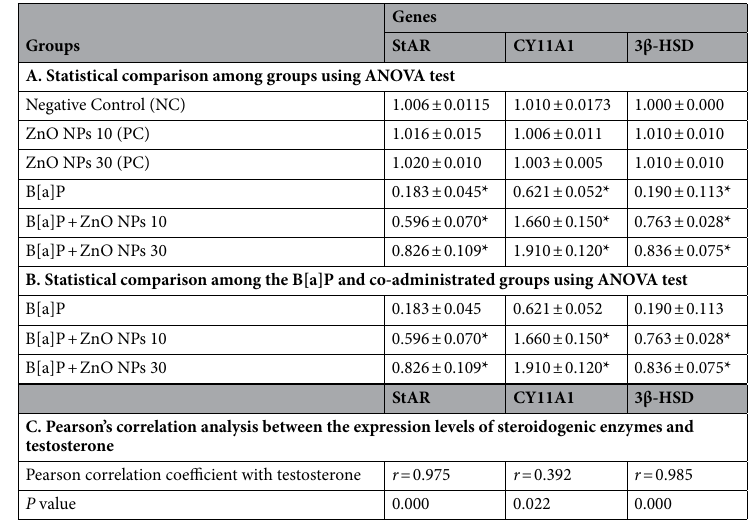
Table 2. Effect of zinc oxide nanoparticles (ZnO NPs) on the relative expression of steroidogenic enzymes in benzo [a] pyrene (B[a]P)-challenged male rats. Values are represented as mean ± standard deviation. Values with superscript * within the same column means a significant difference from the NC group in table A and from B[a] P in table B at P < 0.05. Abbreviations: StAR: Steroidogenic Acute Regulatory protein; CYP11A1: P450Scc cholesterol side-chain cleavage enzyme; 3β-HSD: 3β-Hydroxysteroid Dehydrogenase